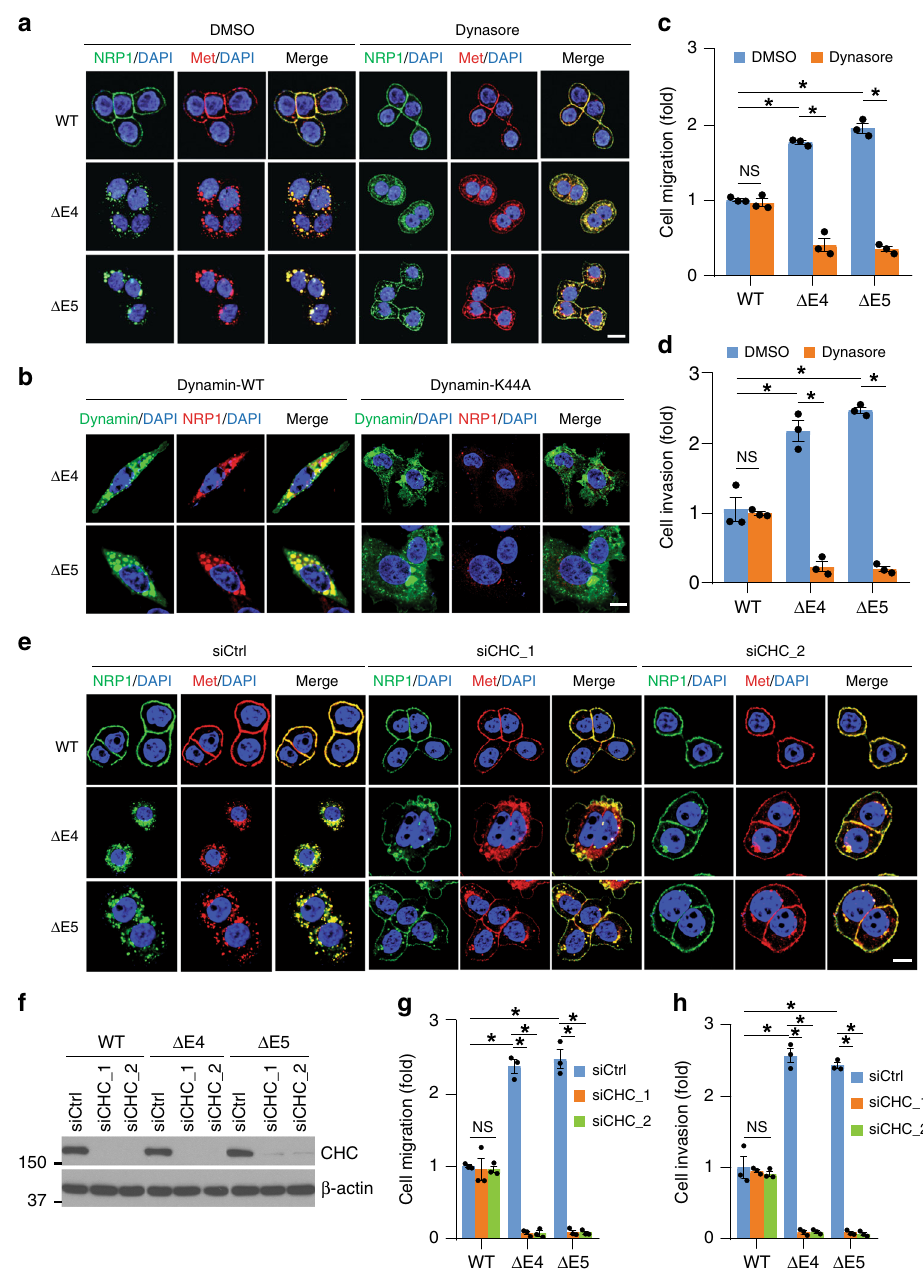
Fig. 7 Blocking endocytosis of the NRP1 variants inhibits CRC cell migration and invasion. a Confocal images of NRP1, Met and DAPI staining in HT29 cells with expression of the indicated NRP1 isoforms that were treated with dynasore (80 µ M) or DMSO as control for 2 h. Scale bars, 10 µ m. b Confocal images of NRP1 with DAPI staining in NRP1- Δ E4- or NRP1- Δ E5-expressing HCT116 cells that were transfected with WT dynamin-2-GFP or dynamin-2 K44A-GFP. Scale bars, 10 µ m. c , d Transwell migration c and invasion d analyses of HCT116 cells with expression of the indicated NRP1 isoforms in the presence of DMSO or dynasore (80 µ M) over 6 h and 30 h of incubation, respectively. The results are expressed as the fold change of cell migration or invasion in the indicated cells relative to the NRP1-WT-expressing cells treated with DMSO. e Confocal images of NRP1, Met and DAPI staining in HT29 cells with expression of the indicated NRP1 isoforms that were transfected with two different sets of CHC siRNA or control siRNA. Scale bars, 10 µ m. f – h HCT116 cells with stable expression of the indicated NRP1 isoforms were transfected with two different sets of CHC siRNA or control siRNA for 36 h, followed by western blot analysis f , or by transwell migration g or invasion h analyses. The results are expressed as the fold change of cell migration or invasion in the indicated cells relative to the NRP1-WT-expressing cells transfected with control siRNA. All graphic data are presented as mean ± s.e.m. ( n = 3 independent experiments). * p < 0.001; NS not signi fi cant using Student ’ s t activity of Met. Similarly, the phosphorylation levels of FAK at NRP1- Δ E5 or vector control. Expression of either NRP1- Δ E4 or Y397 and its interacting protein p130Cas at Y249 were also much NRP1- Δ E5 markedly increased Met phosphorylation levels of higher in both NRP1- Δ E4 and NRP1- Δ E5 relative to the NRP1- Y1234/1235 (kinase domain) and Y1349 (docking site) over that WT (Fig. 8a). These effects were not due to an increase in the seen for NRP1-WT (Fig. 8a), which suggests enhanced kinase